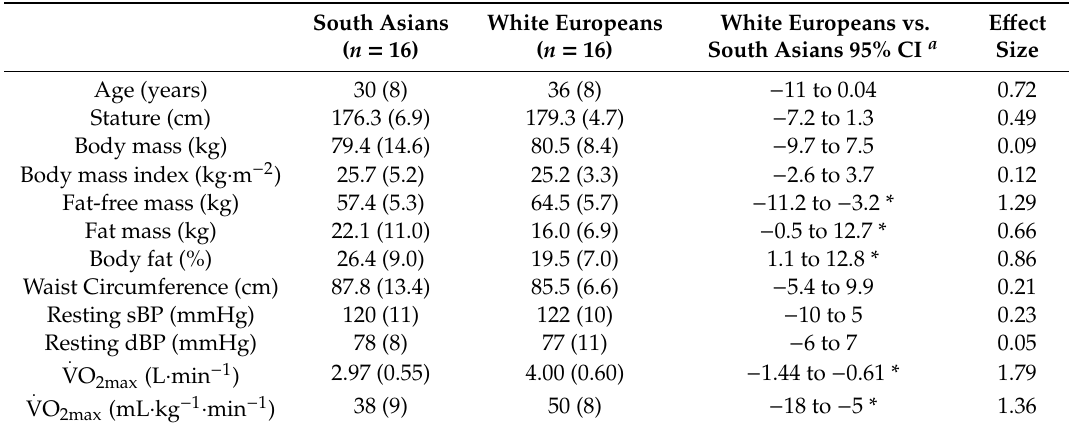
Table 1. Participant